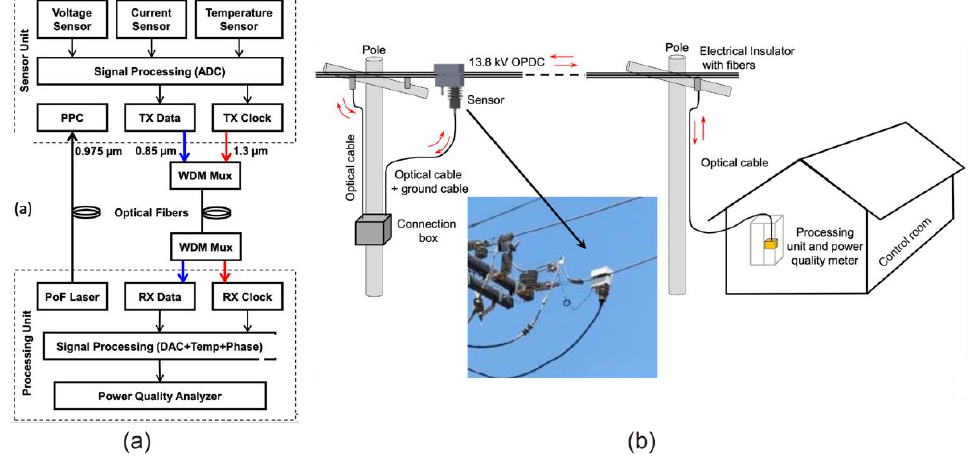
Figure 5. ( a ) Block diagram of optically powered smart sensor. ( b ) Schematic view of link system between sensor and control room. Inset shows photograph of sensor installed in one hybrid aerial fiber/power distribution cable [35].